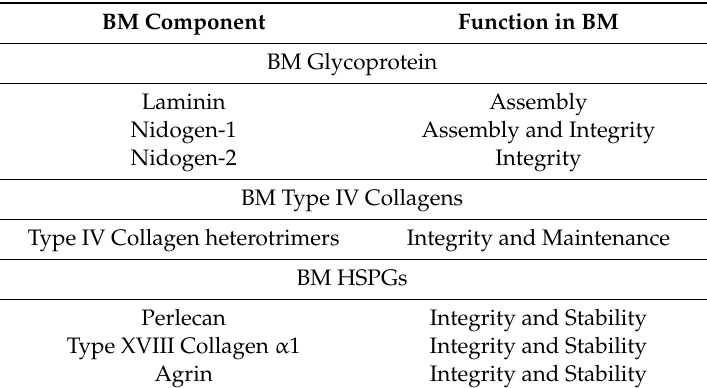
Table 1. List of major BM components and their function within the